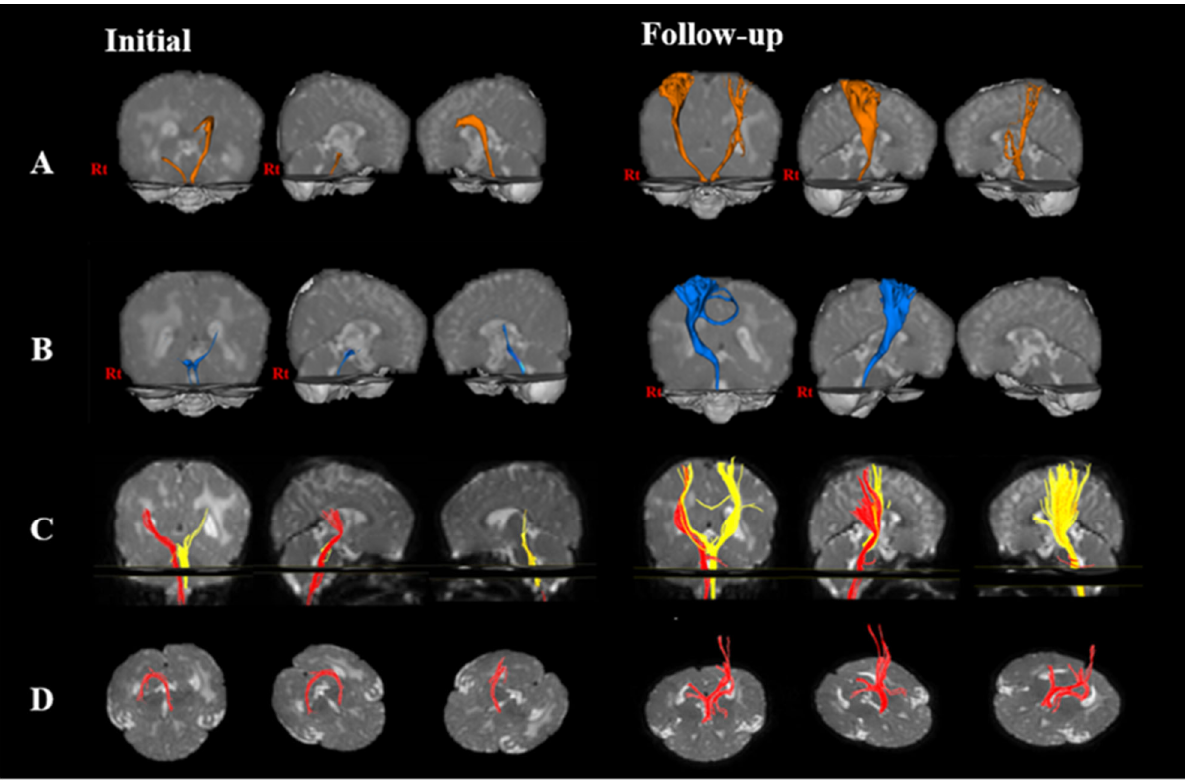
Figure 1. Changes in neural pathway through diffusion tensor imaging (DTI) of a child at initial and follow-up interventions. The initial DTI was performed at 10 months of age, and the follow-up DTI was performed after the intervention was applied for 8 months. ( A ) corticospinal tract; ( B ) corticoreticular pathway; ( C ) medial lemniscus; and ( D ) fornix. Table 2. Changes in gross motor function (unit: